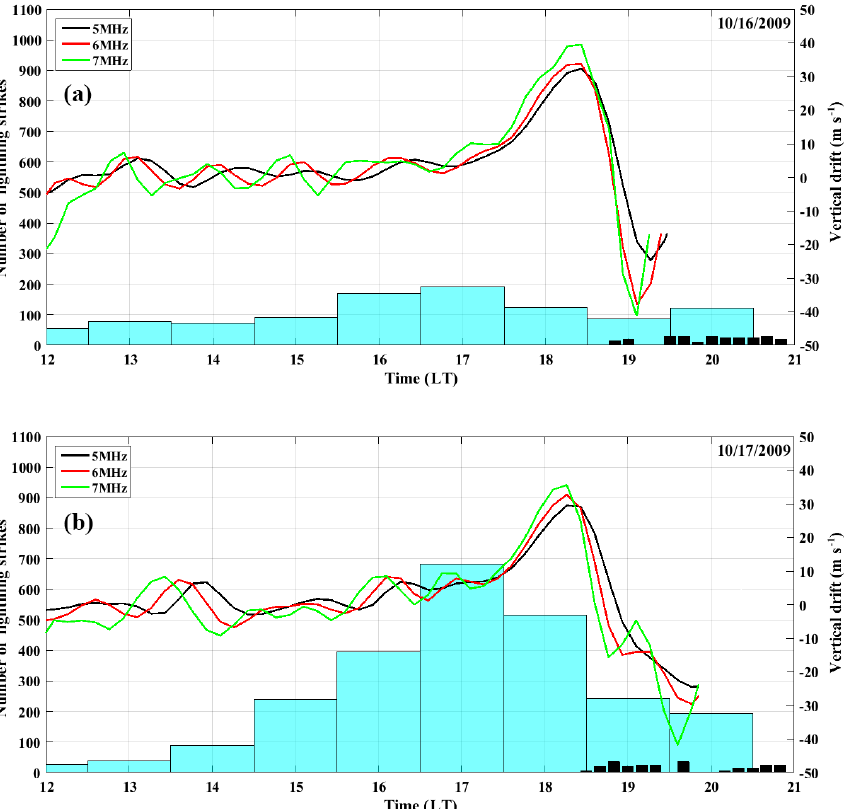
Figure 6. Vertical drift (colored lines), lightning strike activity (cyan bars) and the range of spread F, Q f (black bars), for 16 October 2009 (a) and 17 October 2009 (b) .